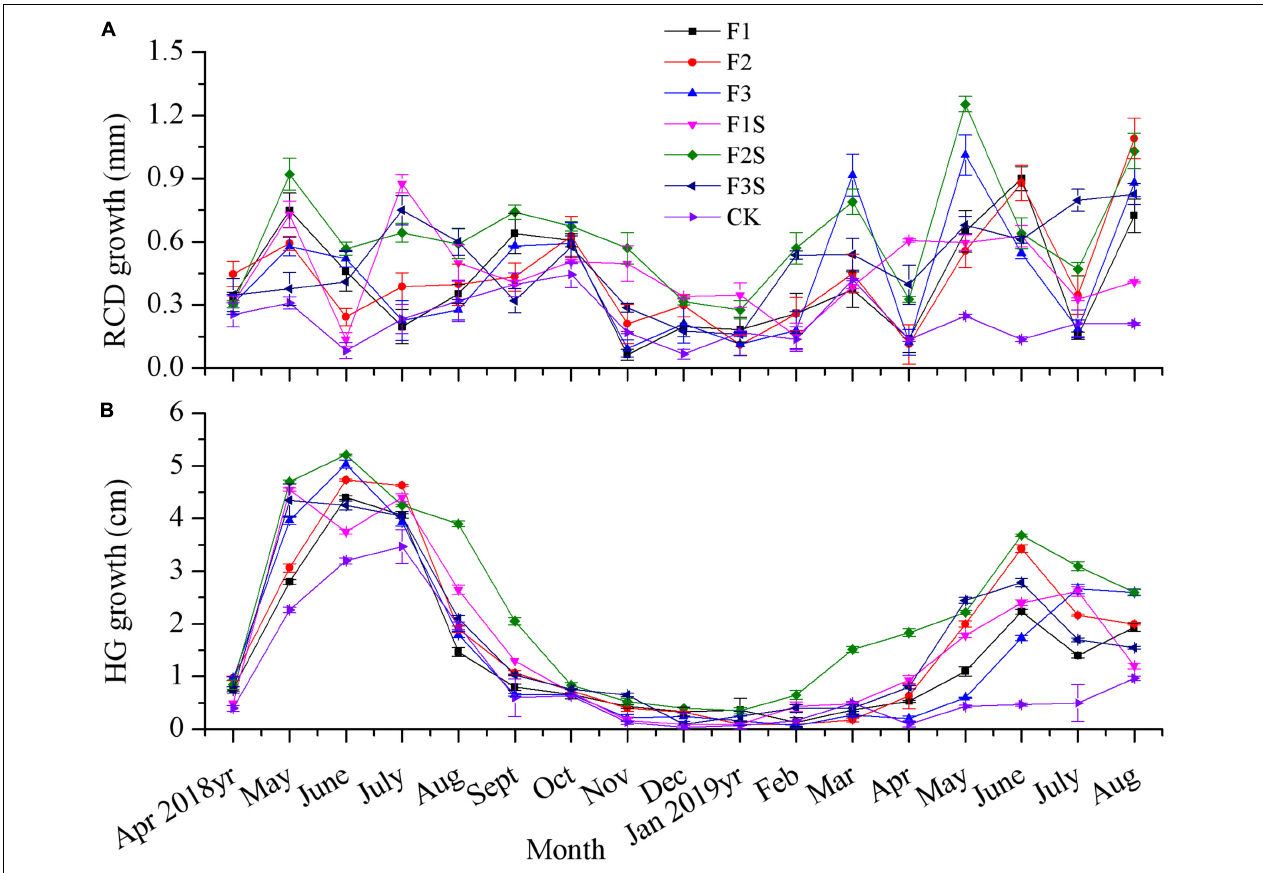
FIGURE 3 | Monthly increased growth in the RCD (A) and HG (B) of P. massoniana seedlings under different treatments.